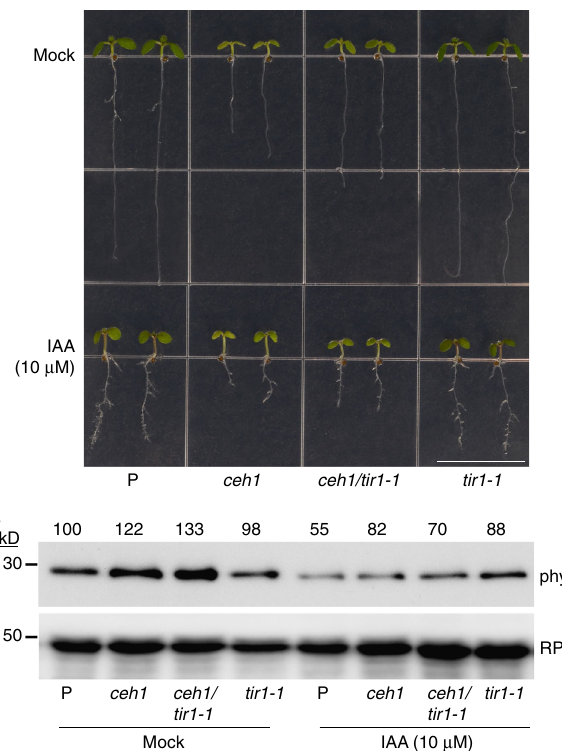
Fig. 6 Auxin regulation of phyB abundance is attenuated in tir1-1 . a Representative images of 7-day-old LD (16 h light/8 h dark)grown P, ceh1 , ceh1 / tir1-1 , and tir1-1 seedlings in the absence (mock, 0.01% ethanol) and the presence of IAA. Scale bar: 1 cm. b Abundance of phyB protein in total protein extracts of P, ceh1 , ceh1 / tir1-1 , and tir1-1 seedlings in the absence (mock) and presence of IAA. RPN6 was used as the loading control. Numbers above the immunoblot image represent normalized phyB abundance in the examined genotypes relative to P